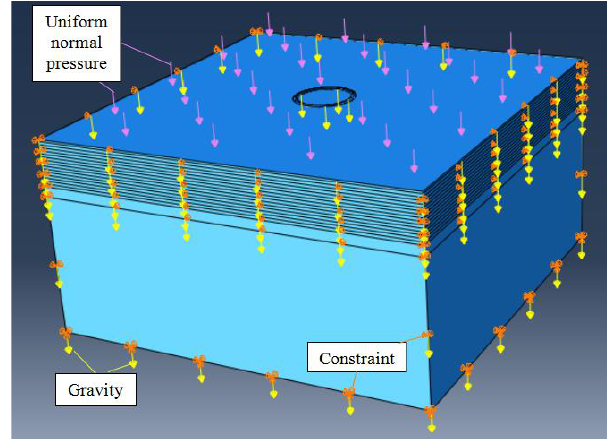
Figure 6. Boundary conditions and loads on the model.